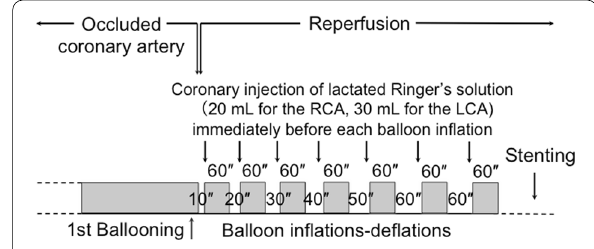
Fig. 1 Overview of the protocol for postconditioning with lactate-enriched blood. LCA, left coronary artery; RCA, right coronary artery. (Reprinted from Koyama et al.